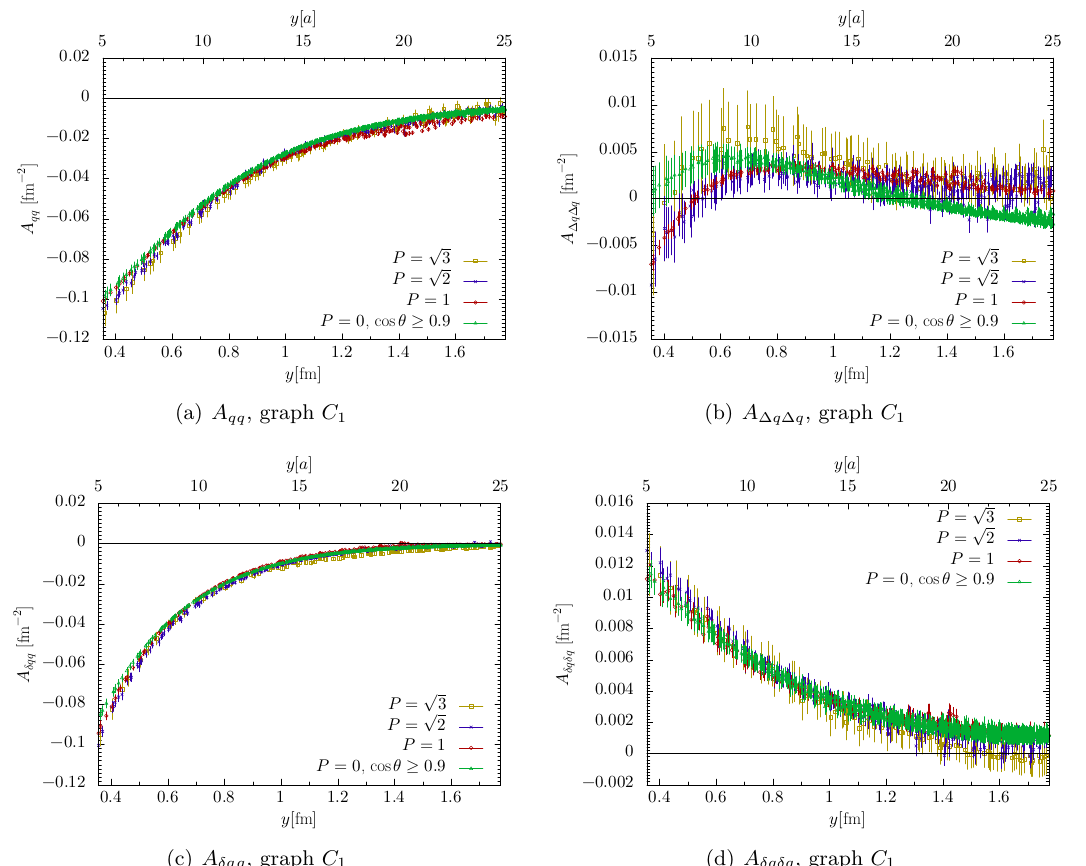
Figure 9 . Comparison of twist-two functions for graph C 1 at different values of the scaled pion momentum P . All points are for py = 0 , L = 40 and light quarks. For B δqδq (not shown), one finds good agreement between all points, with a similar quality as for A qq